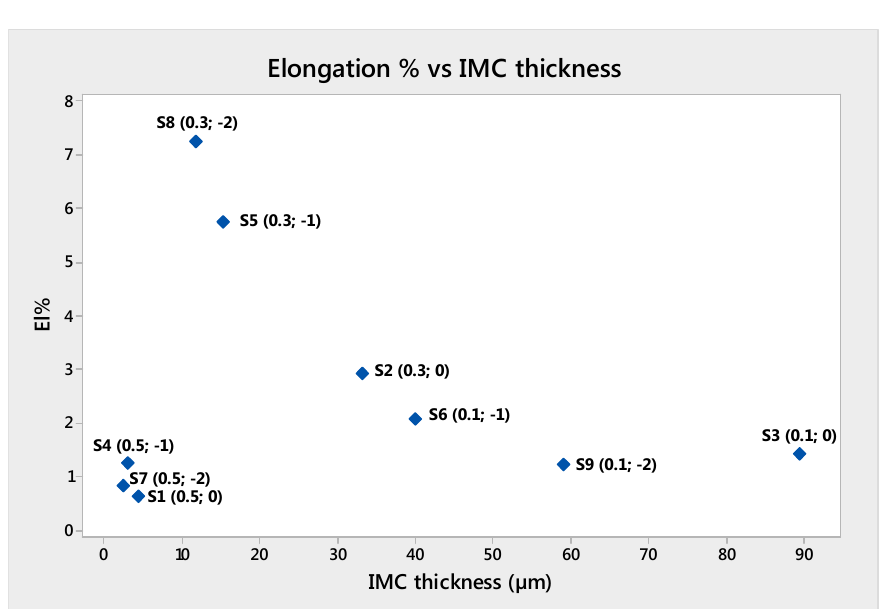
Figure 13. UTS versus IMC thickness.